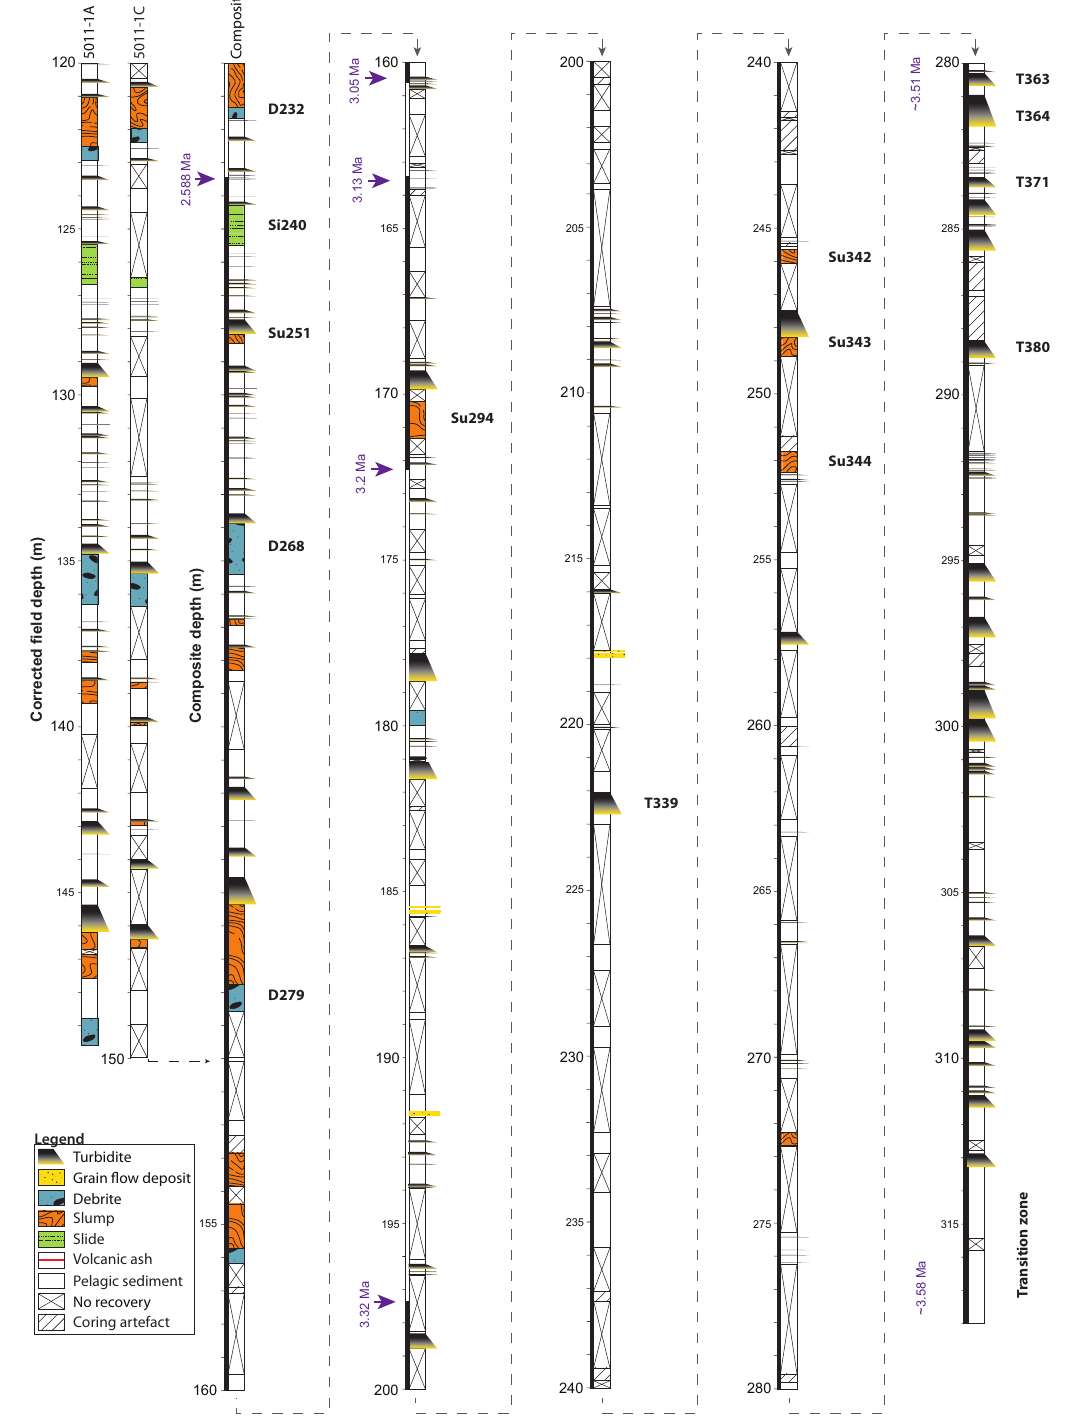
Fig. 2. Distribution of MMDs during the past 3.6Ma from parallel cores at Lake El’gygytgyn (note: Lz1024 against composite depth and 5011-1A to 1C against corrected field depth). Composite of the mass movement events is against composite depth, which explains the small differences compared to the corrected field depth. Numbered mass movement events are mentioned in the text. Paleomagnetic polarity is indicated by black (normal) or white (reversed) rectangles, and ages of reversals (Haltia and Nowaczyk, 2013; Nowaczyk et al., 2013) are